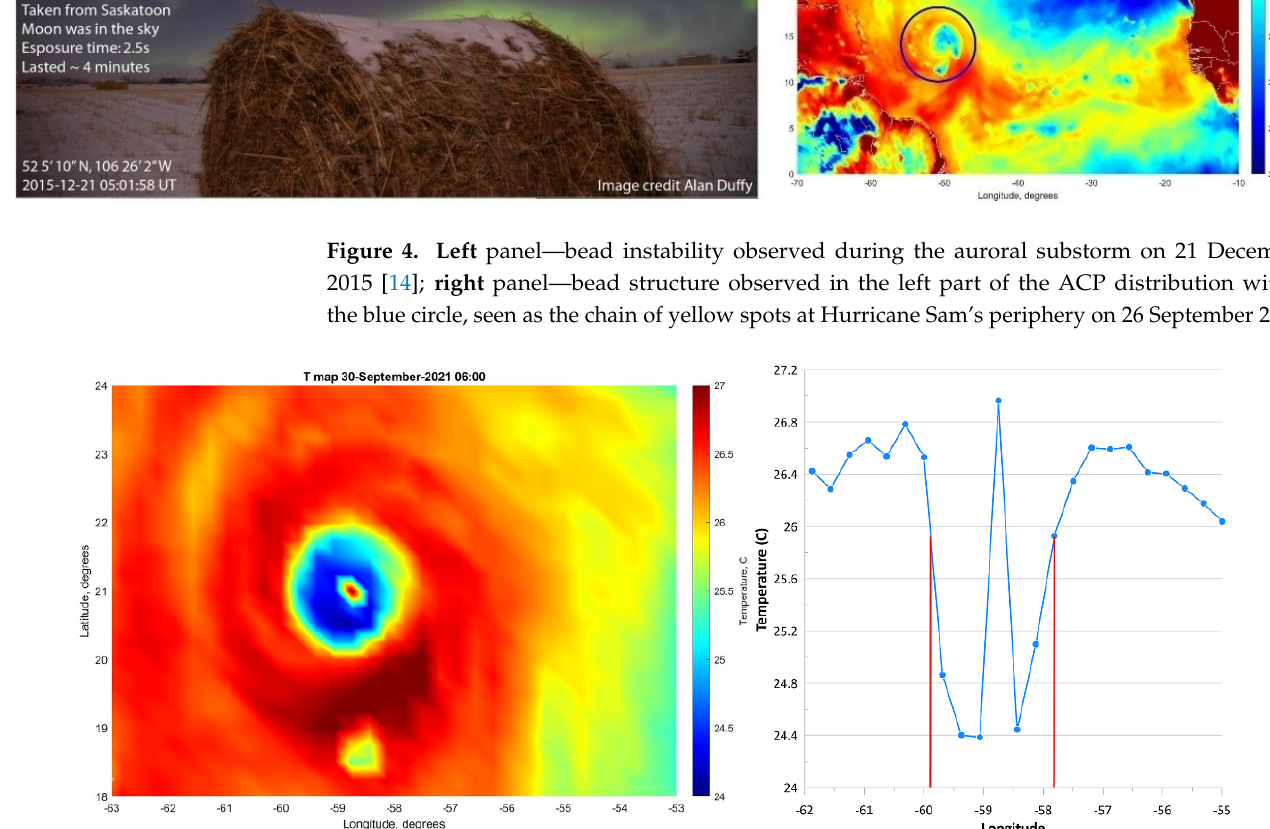
Figure 5. Left panel—temperature distribution inside Hurricane Sam; right panel—cross-section of the temperature distribution through the center of Hurricane Sam at a latitude of 21° S. Red lines show the longitudinal position of the yellow.